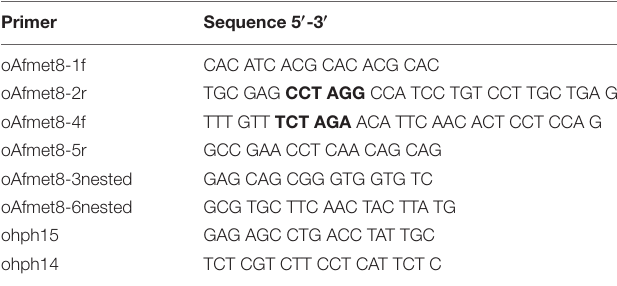
TABLE 1 | Fungal strains used in this study. TABLE 2 | Primers used for generation of (cid:49) met8 and met8 C